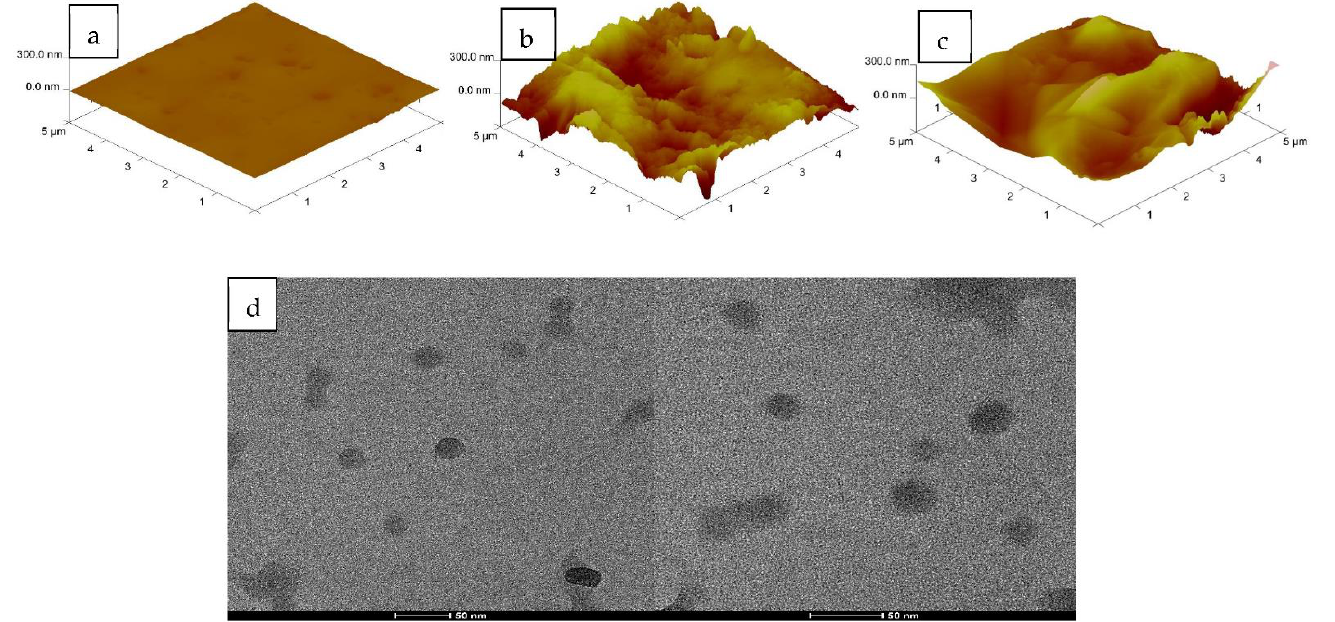
Figure 3. Atomic force microscopy (AFM) images of uncoated ( a ), polymeric nanoparticle coated ( b ), polymeric nanopar- ticle and antibody coated ( c ) QCM chip surfaces, and ( d ) transmission electron microscope (TEM) images of polymeric nanoparticles.